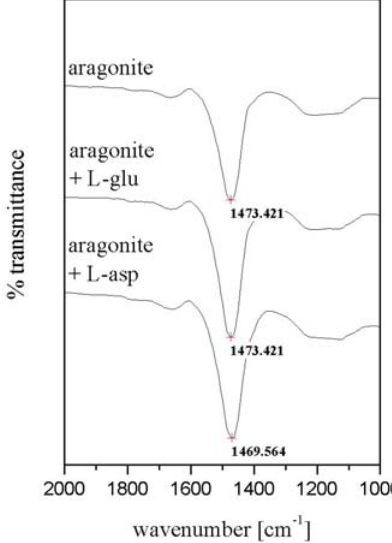
in L -glu and aragonite dissolved in L -asp.